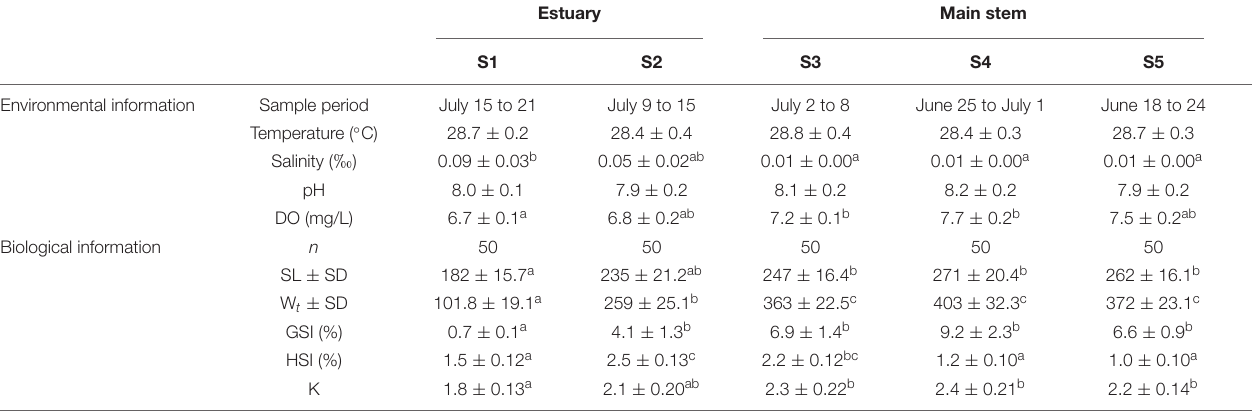
TABLE 1 | Basic environmental information and biological information of gut microbial community pertaining for the different groups studied of Megalobrama terminalis .